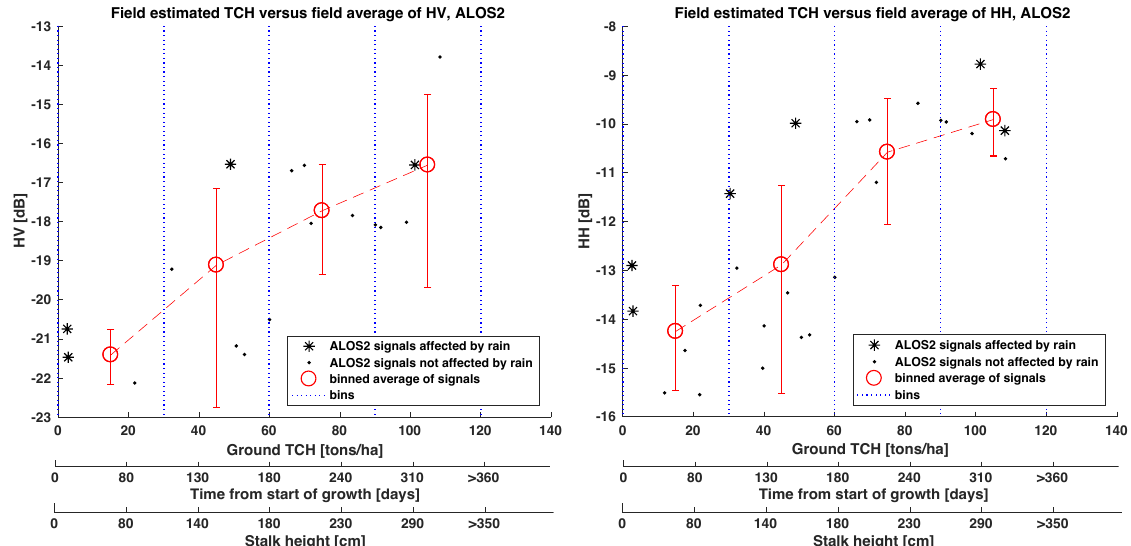
Figure 12. ALOS-2 HV ( left ) and HH ( right ) signals versus TCH, with signal averages taken from combined signals affected by rain and not affected by rain. Approximate and indicative axes of time from start of growth and stalk height were